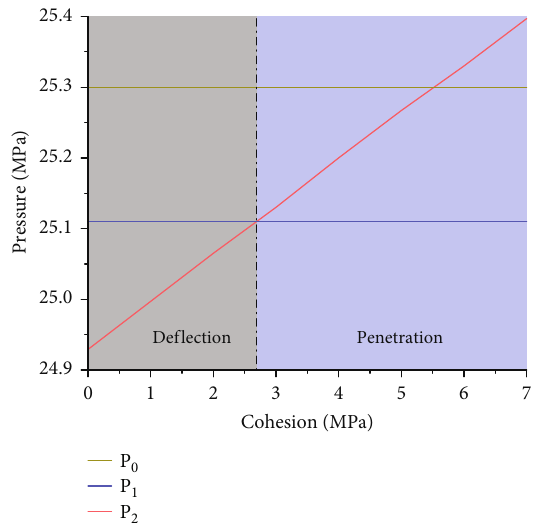
Figure 9: Changes in P 0 , P 1 , and P 2 with interfacial